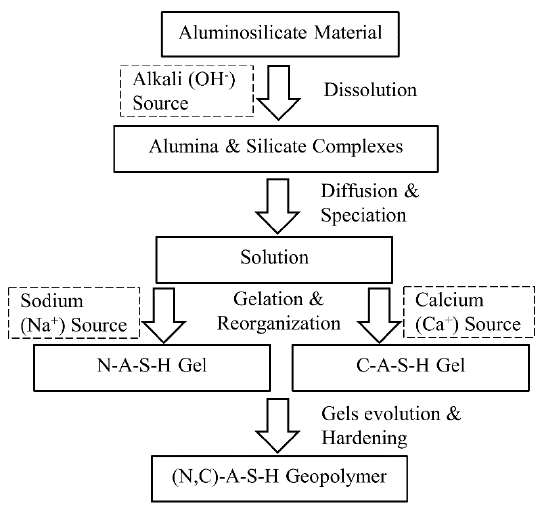
Figure 2. Schematic diagram of the (N, C)-A-S-H geopolymer model.